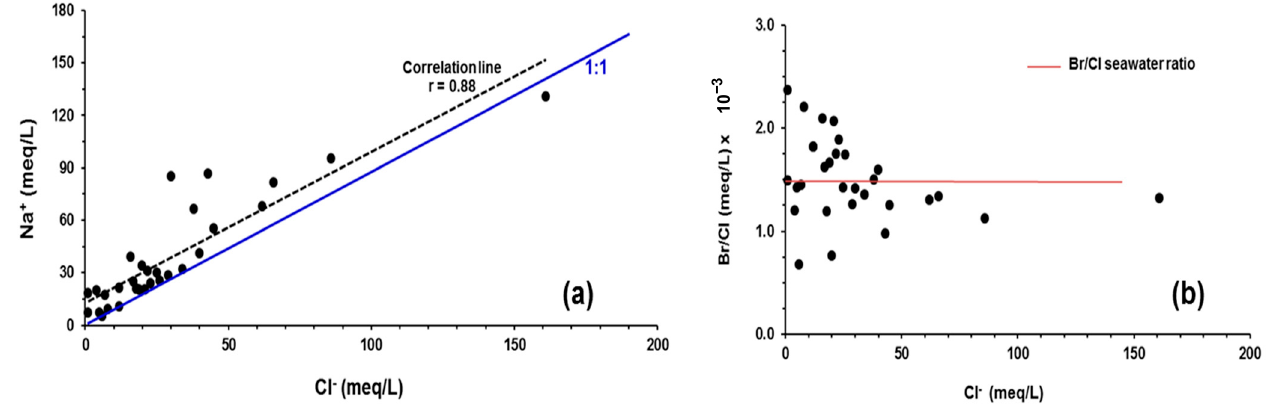
Figure 7. Na vs. Cl ( a ) and Br/Cl vs. Cl ( b ) diagrams for groundwater (Mio–Pliocene aquifer) of the study region.